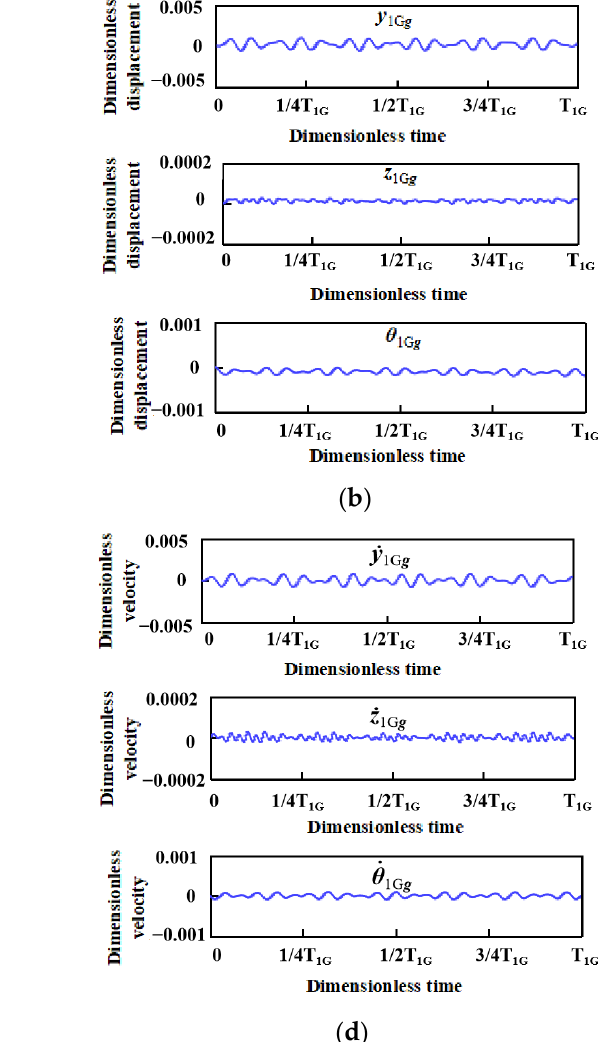
( d ) Figure 9. State space of the first-stage gear pair Z 3 and Z 4 : ( a ) vibration displacement of driving gear; ( b ) vibration displacement of driven gear; ( c ) vibration velocity of driving gear; ( d ) vibration veloc- ity of driven gear.